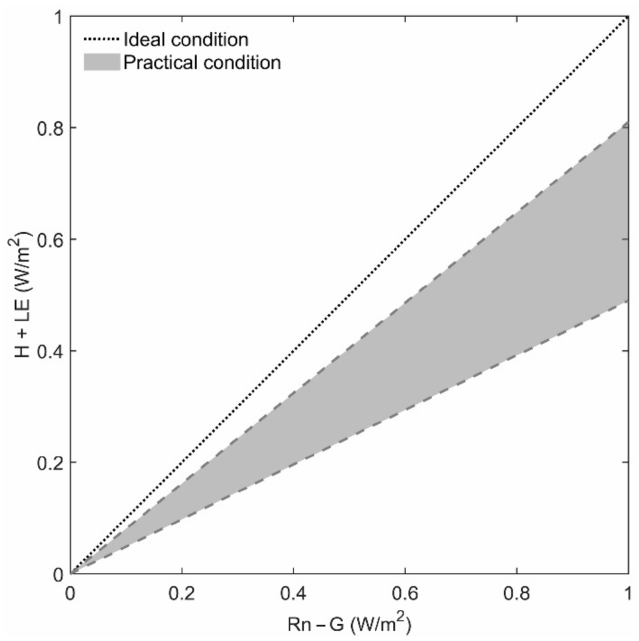
Figure 2. Surface energy closure obtained by the OLS